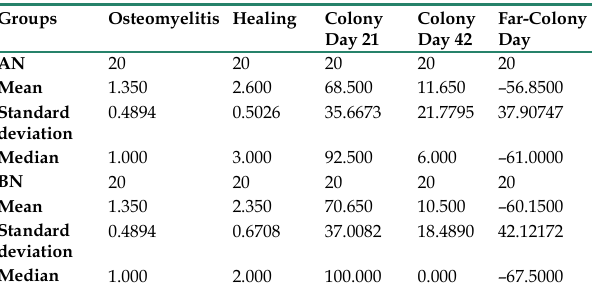
Table 2 : Comparison of the healing scores and number of colonies between the two